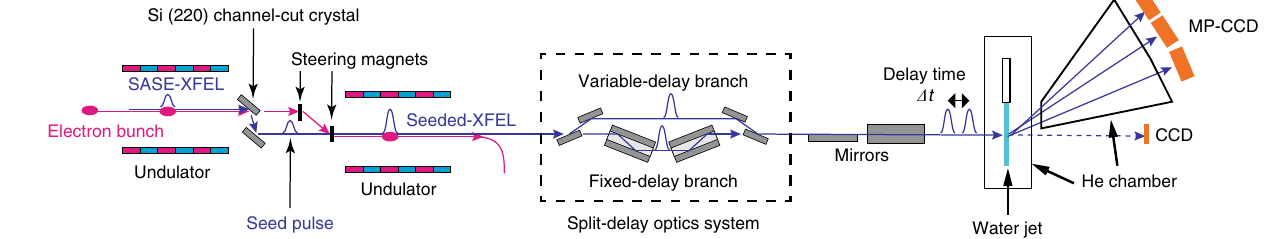
Fig. 1 Experimental setting of XPCS using split-and-delay optics and re fl ection self-seeding at BL3, SACLA 18 . The seed pulse was produced by monochromatizing the SASE from the upstream undulator segments. Then the seed was ampli fi ed in the downstream undulators. The details are described in ref. 36 . The ampli fi ed X-ray pulse was split into two sub-pulses using the SDO 31 . The sub-pulses with a delay time Δ t are focused by mirrors 40 and hit the water jet. Scattered X-rays were recorded by the MPCCDs 42